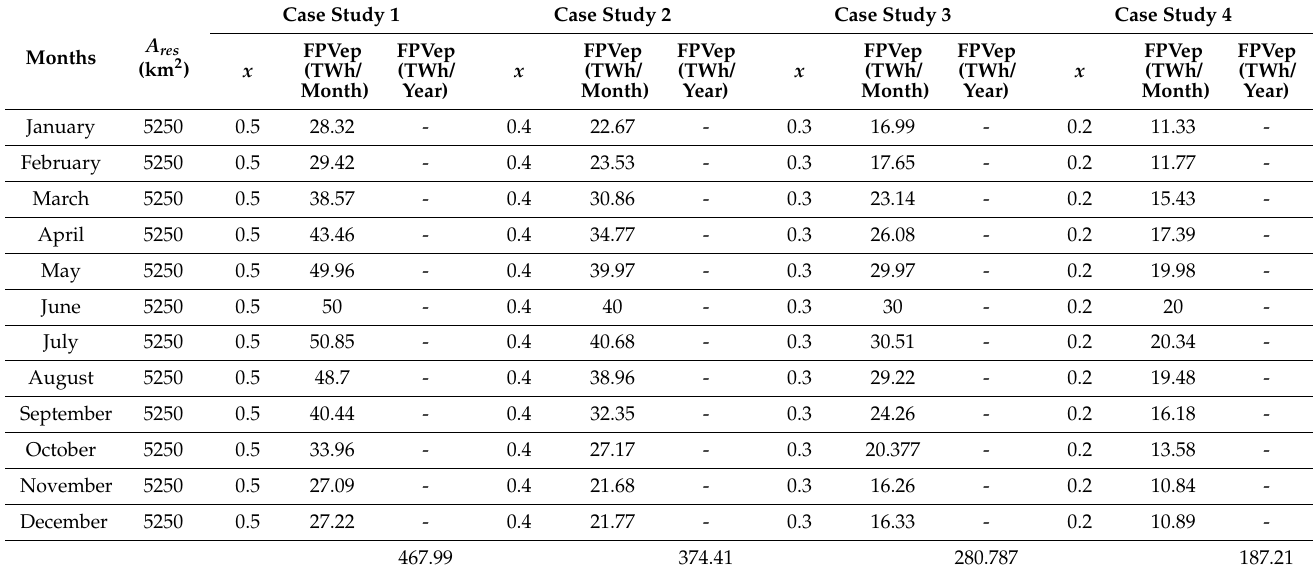
Table 4. Floating photovoltaic (FPV) panels generation